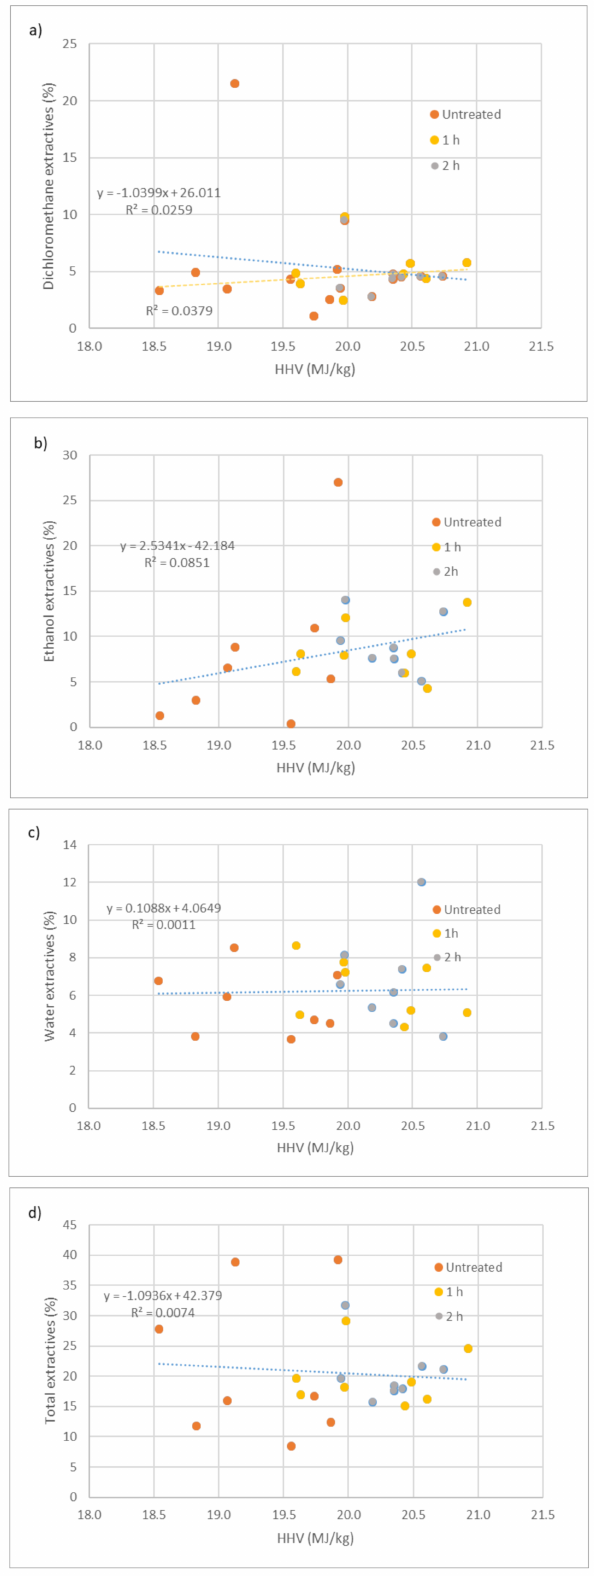
Figure 2. Variation of HHV with extractives of untreated and heat-treated woods: ( a ) Dichloromethane extractives; ( b ) ethanol extractives; ( c ) water extractives; ( d ) total